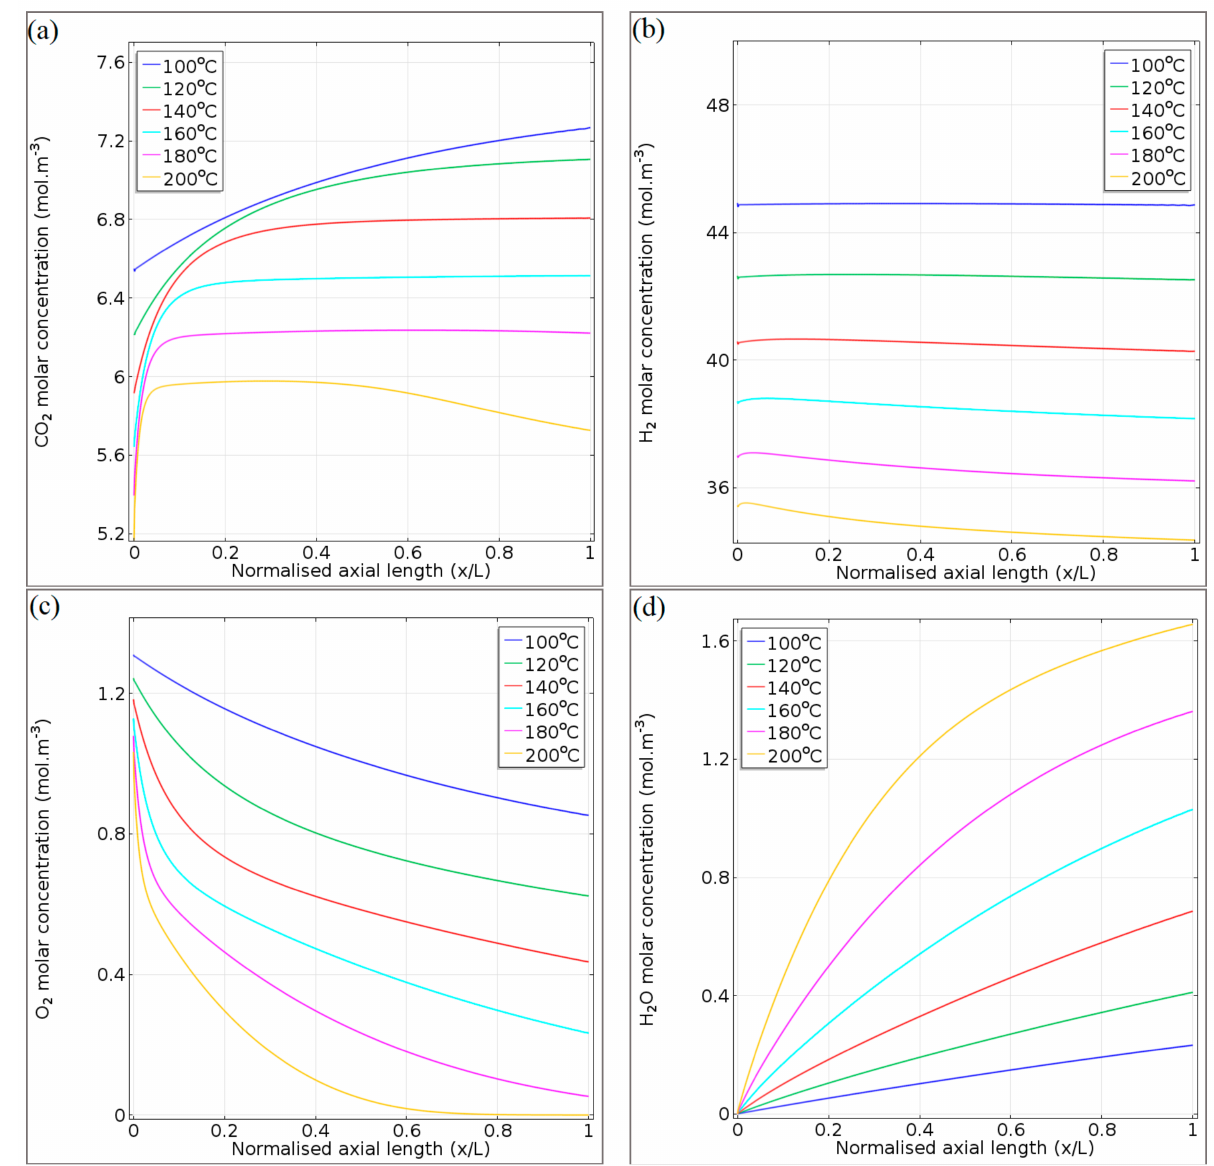
Figure 12. Concentration profiles of ( a ) CO 2 , ( b ) H 2 , ( c ) O 2 , and ( d ) H 2 O, at 65.2 NL g cat − 1 h − 1 and 100–200 ◦